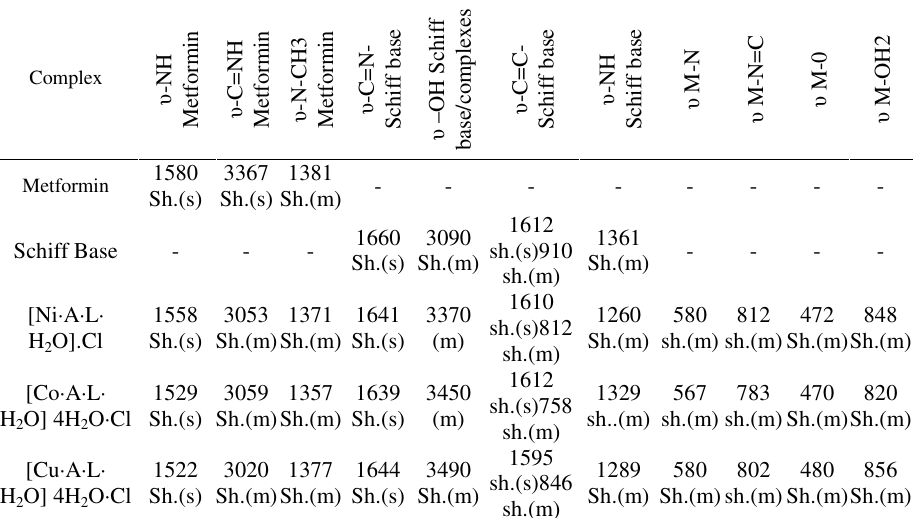
Table 2. Infrared spectral data of the metal complexes (cm -1